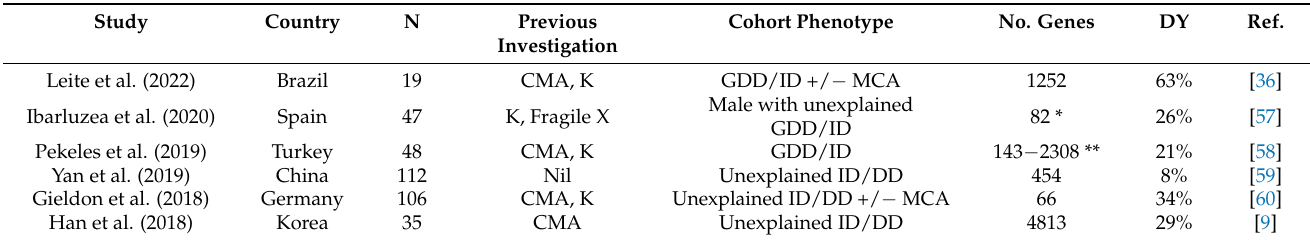
Table 4. Targeted gene panels of individuals with intellectual disabilities/developmental disabilities in recent